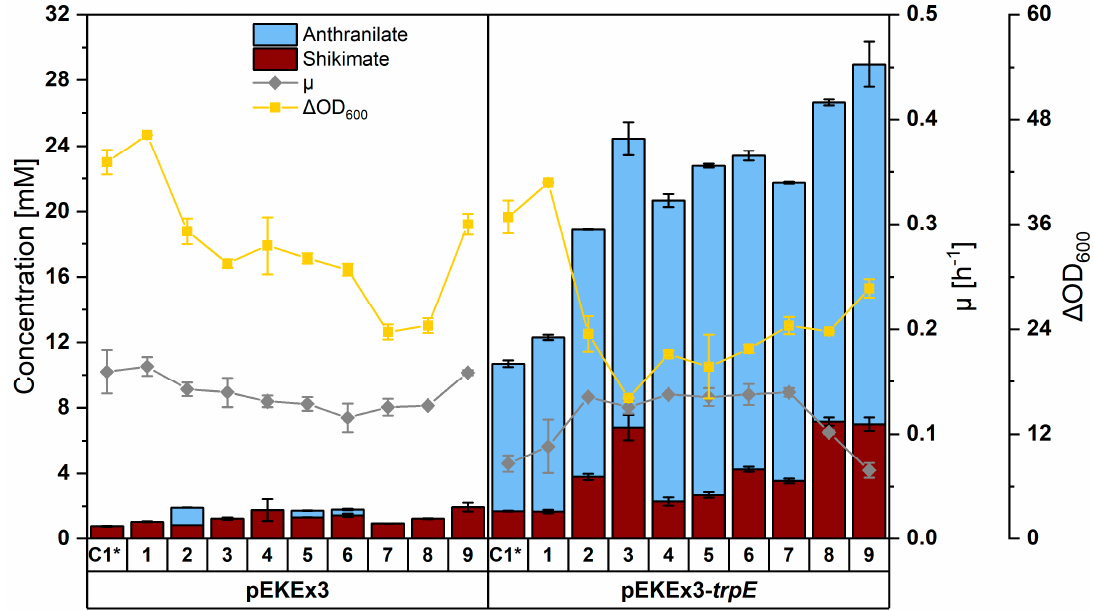
Figure 3. Production of shikimate (maroon bars) and anthranilate (light blue bars), maximal specific growth rate (gray diamonds) and biomass formation (yellow squares) by C. glutamicum strains C1* and ARO01 to ARO09 carrying either pEKEx3 (left panel) or pEKEx3- trpE FBR (right panel) were grown in shake flasks in CGXII minimal medium with 40 g·L − 1 glucose for 48 h. Means and arithmetic errors of duplicate cultures are shown.